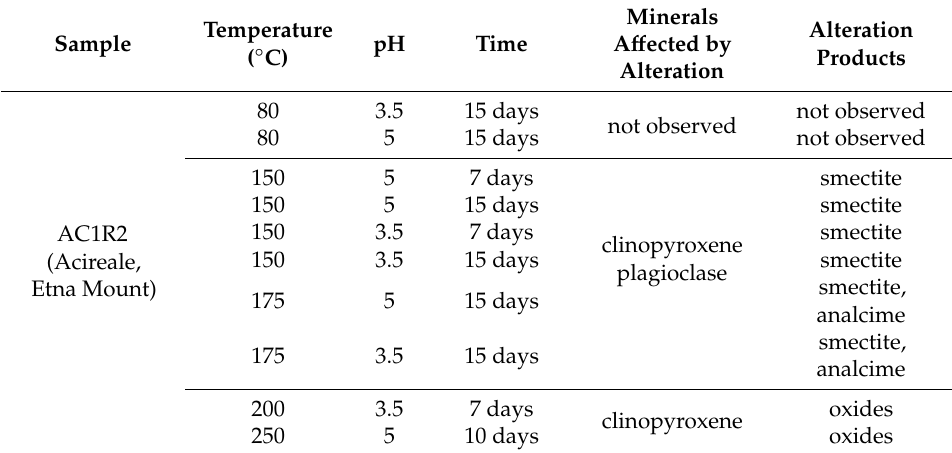
Table 1. Experimental run conditions and related alteration products after AC1R2, fresh